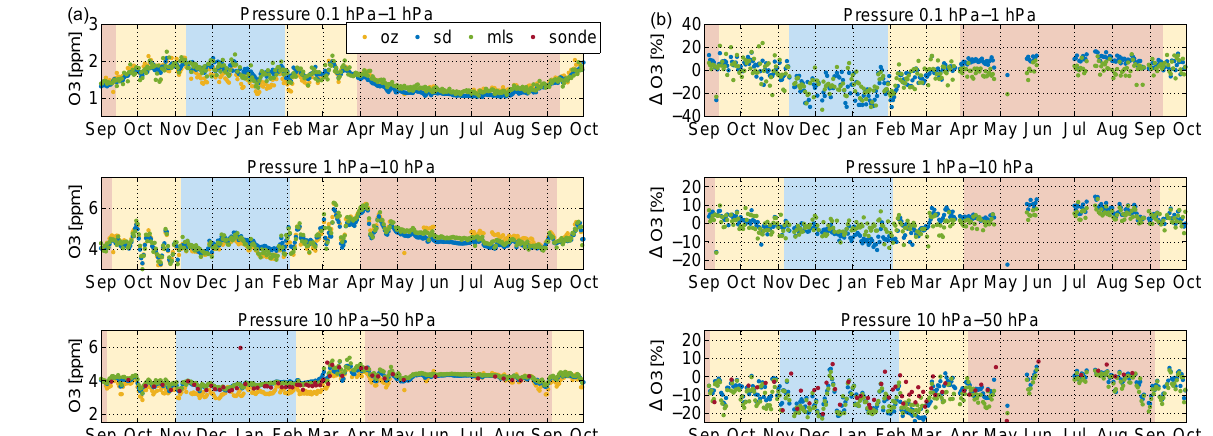
Figure 6. Same as in Fig. 5 but for OZORAM as reference